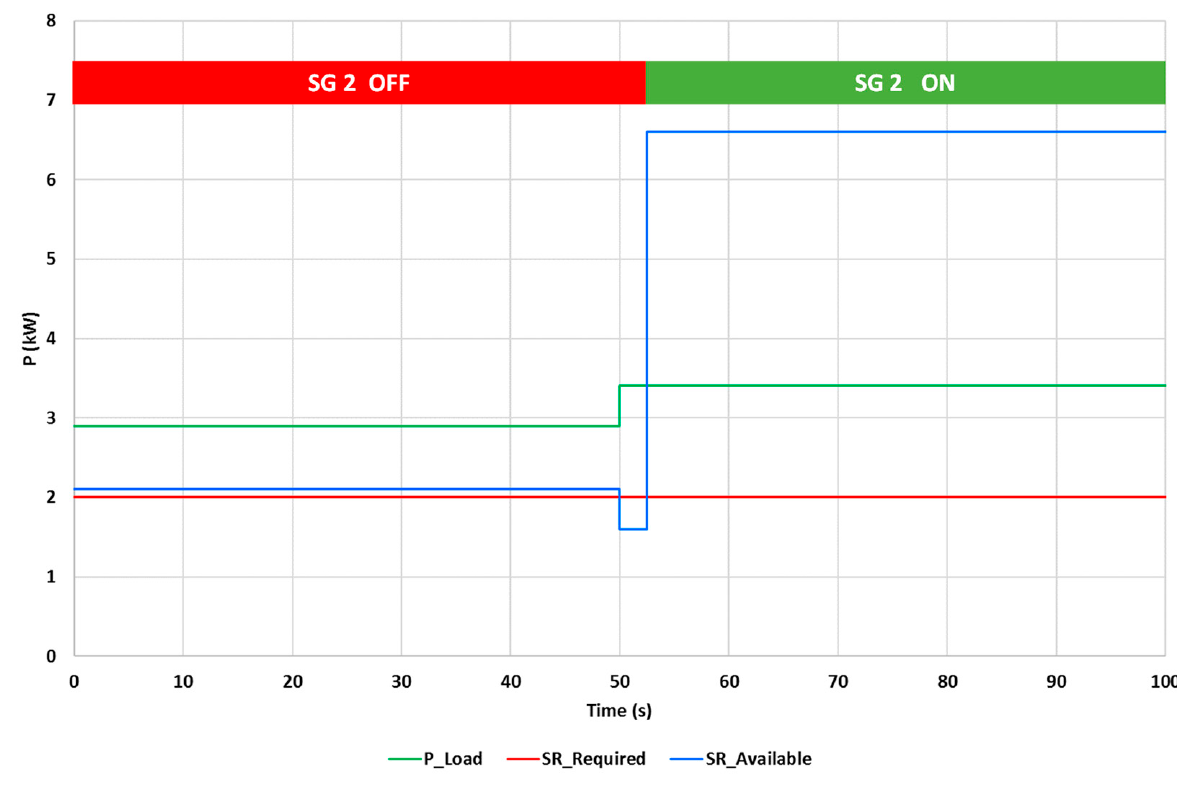
Figure 18. Power demand, spinning reserve (SR) values and activation status of synchronous generator 2 (SG2), in the case without non-priority loads (conventional method).